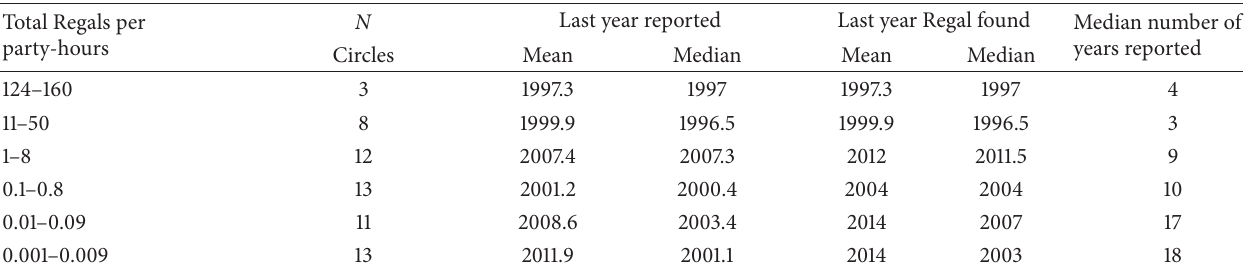
Table 4: Number of circles in each category of Regal abundance (calculated as total Regal individuals reported per total party-hours), mean and median year that a count was last reported from those circles, and that Regal Fritillary was last reported in those circles. Spearman rank correlations of total Regal individuals per total party-hours per circle with last year reported ( 𝑟 = −0.41920 , 𝑃 < 0.01 ) and with last year Regal reported ( 𝑟 = +0.03631 , 𝑃 > 0.10 ) and with number of years reported ( 𝑟 = −0.50137 , 𝑃 < 0.01 ), 𝑁 = 60 for